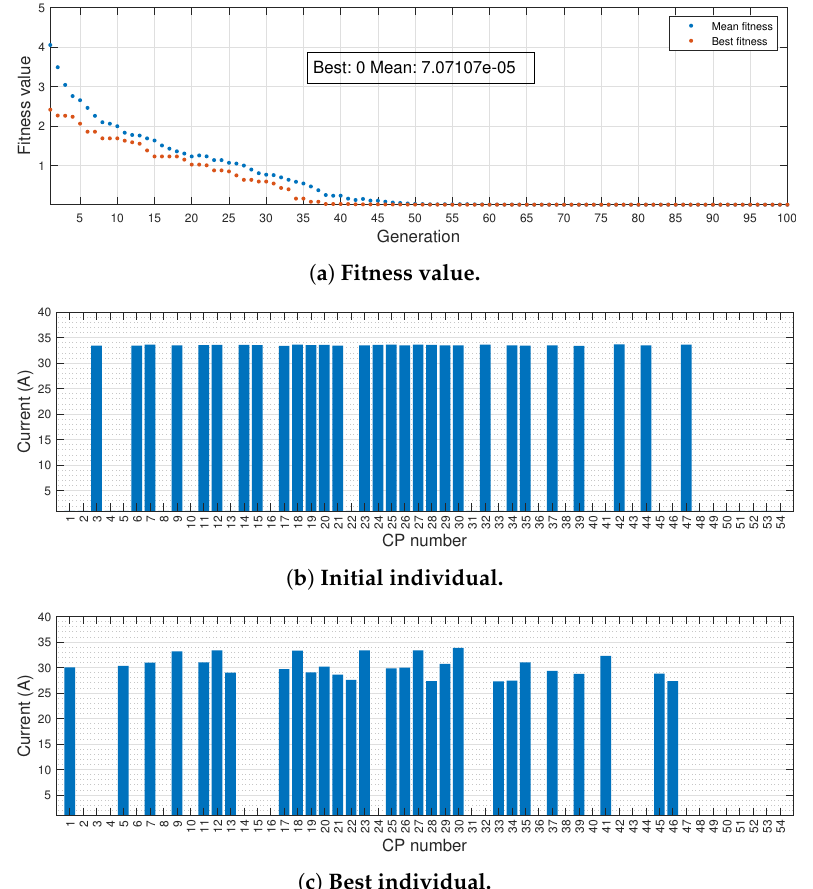
( c ) Best individual. Figure 14. Convergence plots of GA. ( a ) Fitness value. ( b ) Initial individual. ( c ) Best